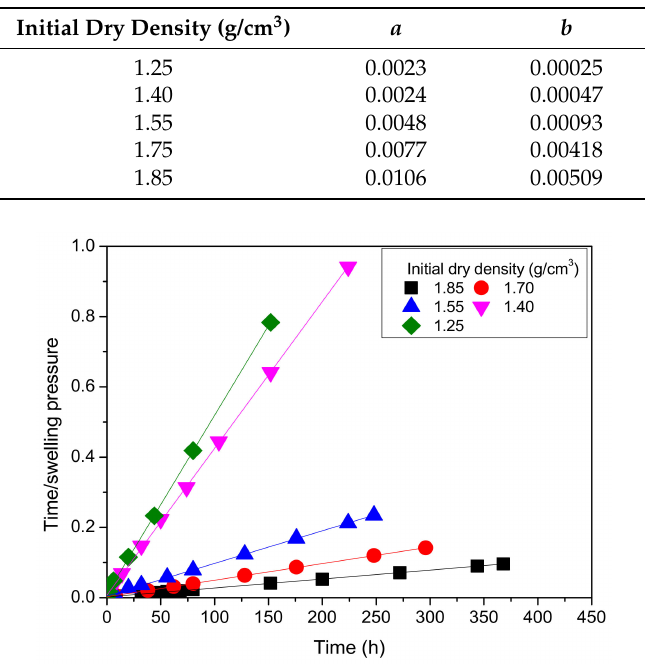
Figure 14. Relationship between the ratio of time to swelling pressure and swelling time for MB specimens with different dry densities under saline water